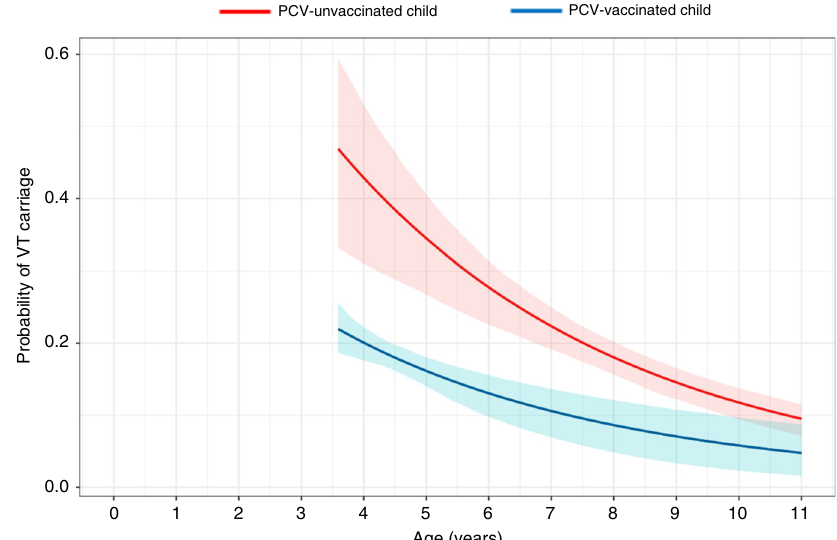
Fig. 4 Modelling the relationship between a child ’ s probability of VT carriage and age. Estimated probabilities and pointwise 95% con fi dence intervals (shaded regions) of the probability of an individual child ’ s vaccine-serotype (VT) carriage as a function of a child ’ s age (years), for an unvaccinated child (red line) and a vaccinated child (blue line). The fi tted line for unvaccinated children includes the range of the empiric data. The fi tted line for vaccinated children is left censored at 3.6 years old and extrapolated beyond the oldest vaccinated child (7.9 years old). The model shows signi fi cantly different estimated probabilities of VT carriage for an individual (distance between lines), while the estimated population-level half-life of VT carriage (derived from individual carriage probability data; refer to Table 3 in manuscript) translates to very similar estimates among PCV-vaccinated (3.34 years) and PCV-unvaccinated (3.26 years) children.